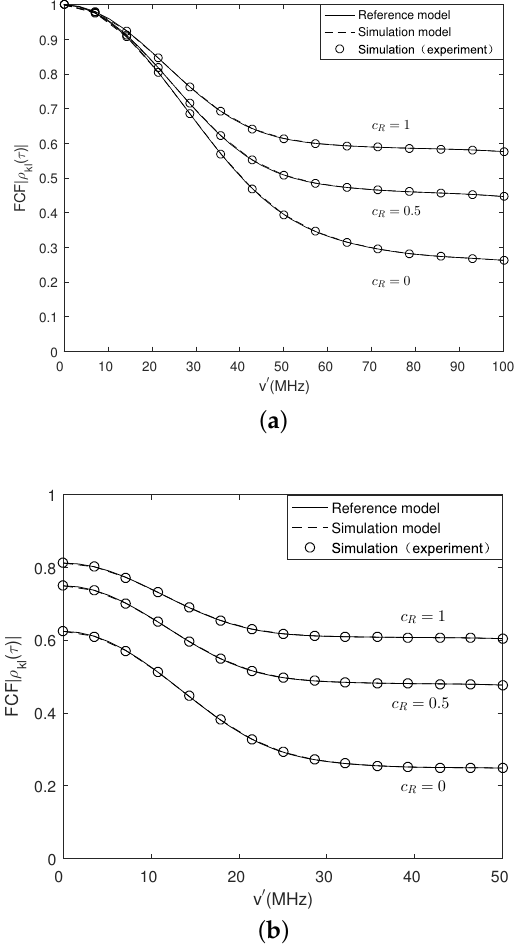
Figure 14. FCF of SRT and without arched ceiling for Rice factors ( c R ) . ( a ) FCF of SRT. ( b ) FCF of SRT without